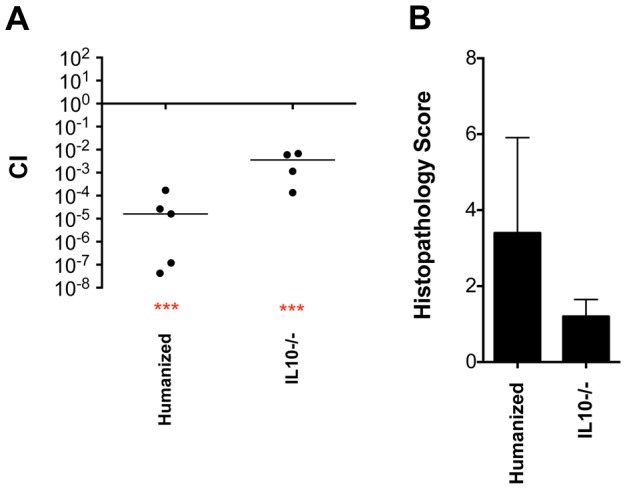
Phenotype of a fraB1::kan mutant in the cecum of “humanized” and IL10 knockout mice.109 wild-type IR715 vs fraB1::kan mutant MA59 in “humanized” Swiss Webster mice (germ free mice inoculated orally with a human fecal sample), or C57BL/6 IL10 knockout mice, as indicated, via the i.g. route and recovered from cecum on day 3 post-infection. A) Each data point represents the CI from one mouse with the median shown by a horizontal line. Statistical significance of each group being different than 1 was determined by using a one sample Student's t test. *** = P value<0.001. B) Histopathology scores of mice from panel A. Error bars represent mean+SD.